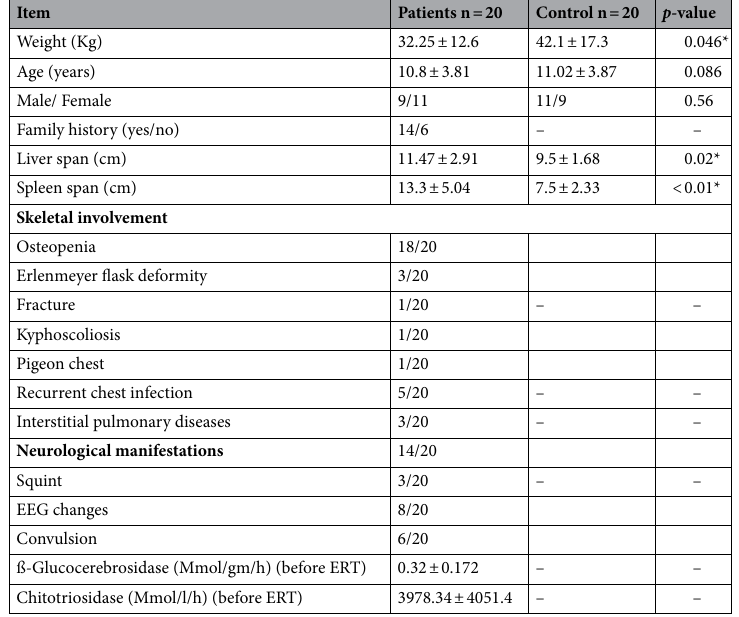
Table 1. Descriptive clinical and laboratory data of GD patients. Values represent mean ± SD. Independent T-test is used in comparison between two groups. n number, Kg kilogram, cm centimetre, g gram, dL decilitre,